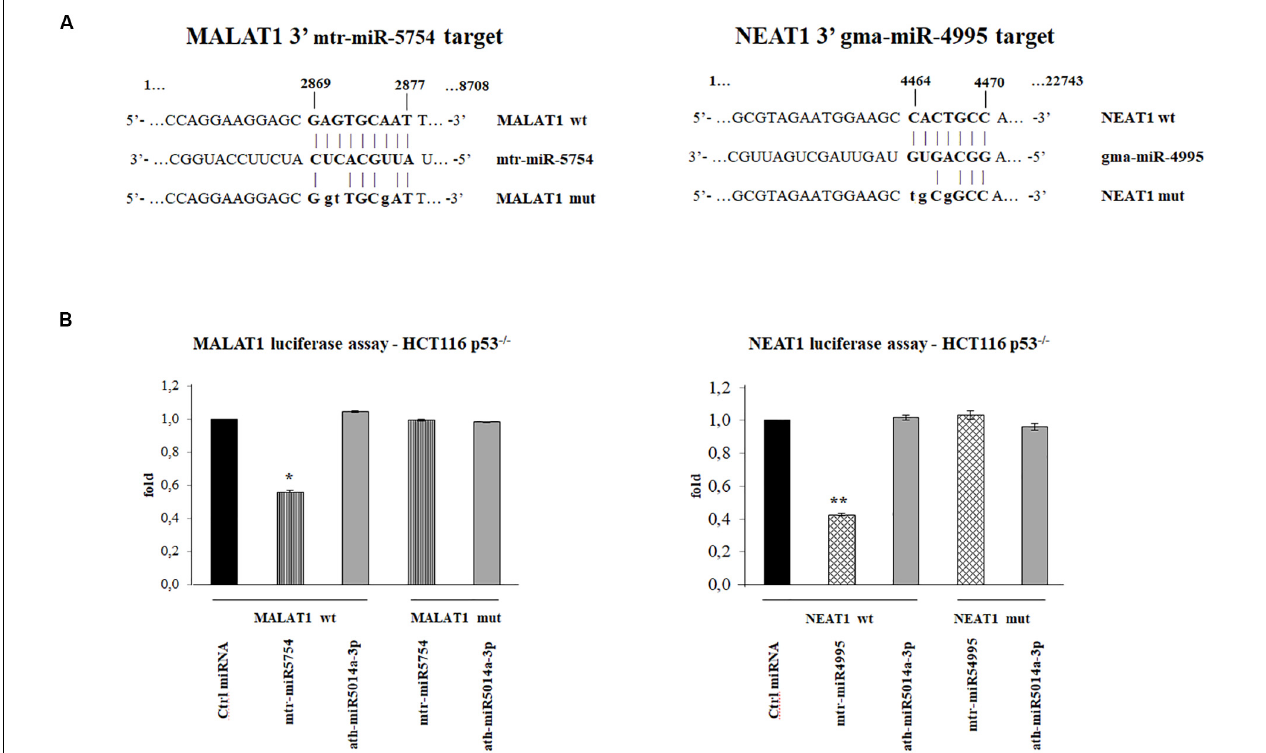
FIGURE 4 | Plant microRNAs (miRNAs) mtr-miR-5754 and gma-miR-4995 regulate metastasis-associated lung adenocarcinoma transcript 1 (MALAT1) and nuclear paraspeckle assembly transcript 1 (NEAT1) stability. (A) Schematic representation of the putative wild-type and mutated sequences at 3 (cid:48) -end of MALAT1 and NEAT1, complementary to 5 (cid:48) end of the plant mtr-miR-5754 and to gma-miRNA-4995, which were cloned into the pMIR luciferase reporter construct containing downstream the luciferase gene. In bold is the sequence alignment between the plant miRNAs 5 (cid:48) end sequences and their specific binding regions. The letters in lowercase represent the mutagenized nucleotides. (B) HCT116 p53 − / − cells were transfected with pMIR luciferase reporter construct containing MALAT1 3 (cid:48) region together with negative control miRNA, mtr-miR-5754, or unspecific plant miRNA. The HCT116 p53 − / − cells were transfected with pMIR luciferase reporter construct containing NEAT1 3 (cid:48) region together with negative control miRNA, gma-miR-4995, or unspecific plant miRNA. 48 h after transfections, cells were lysed, and luciferase activity was determined. Transfection efficacy was normalized by Renilla luciferase activity. Data represent the averages of three independent experiments with their standard deviations (* p < 0.05 and ** p <